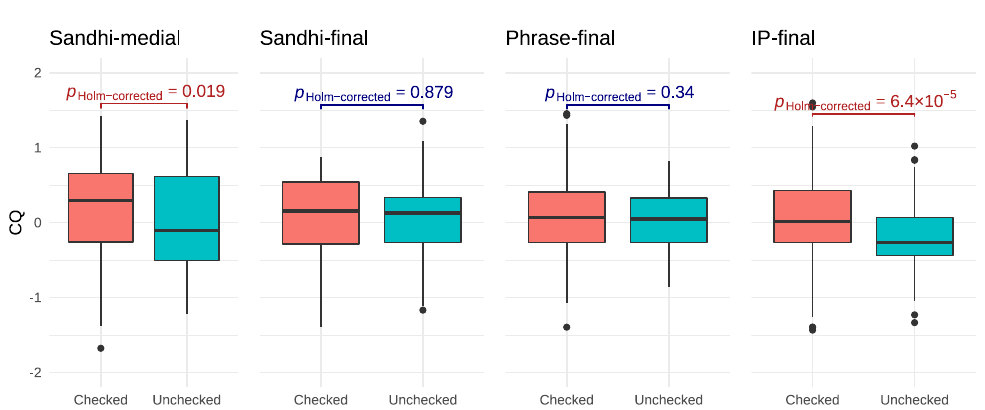
Figure 6. The variation of CQ influenced by phonemic type and prosodic position. Significant p ‑ values ( p ⩽ 0.05 ) are marked in red, which indicates that the CQ difference between checked and unchecked syllables is significant in that prosodic